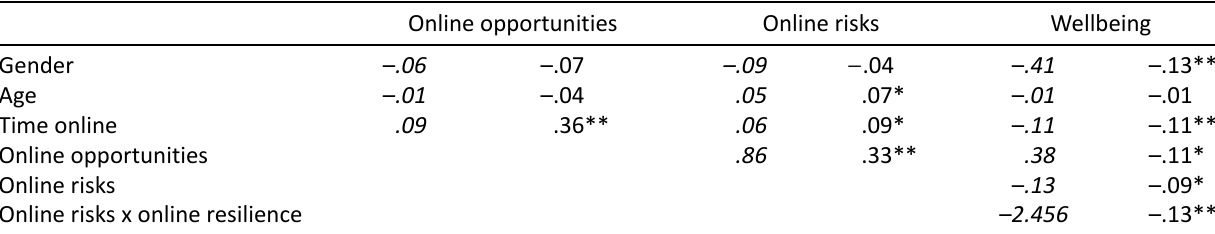
Table 1. Unstandardized and standardized beta’s and significance levels of the structural equation model for online oppor- tunities, online content risks, online resilience, and